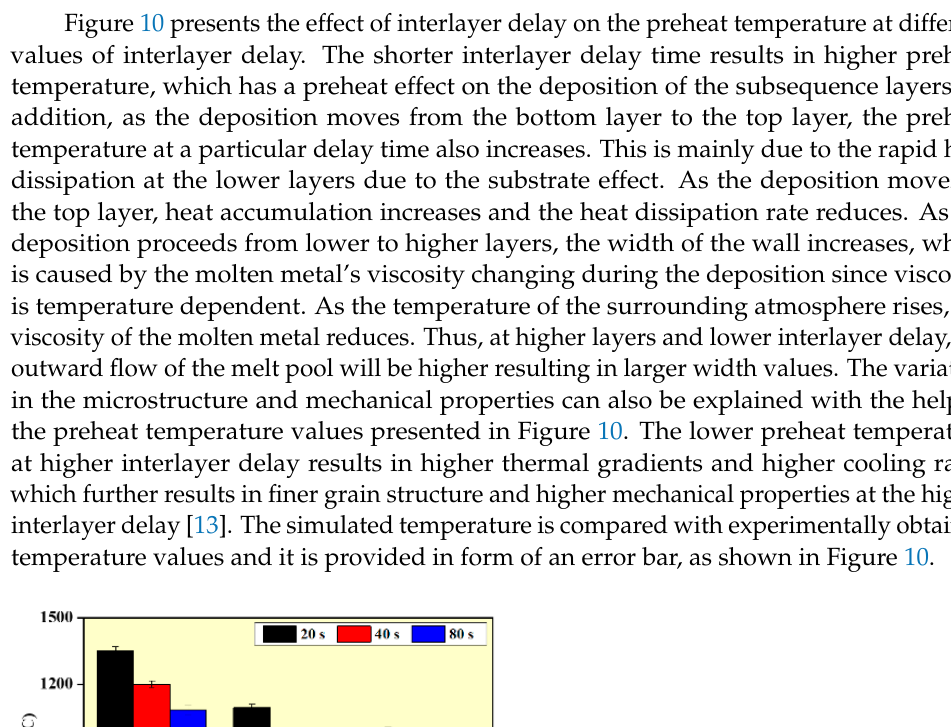
Figure 9. Schematics illustrating the heat distribution in a WAAM process.